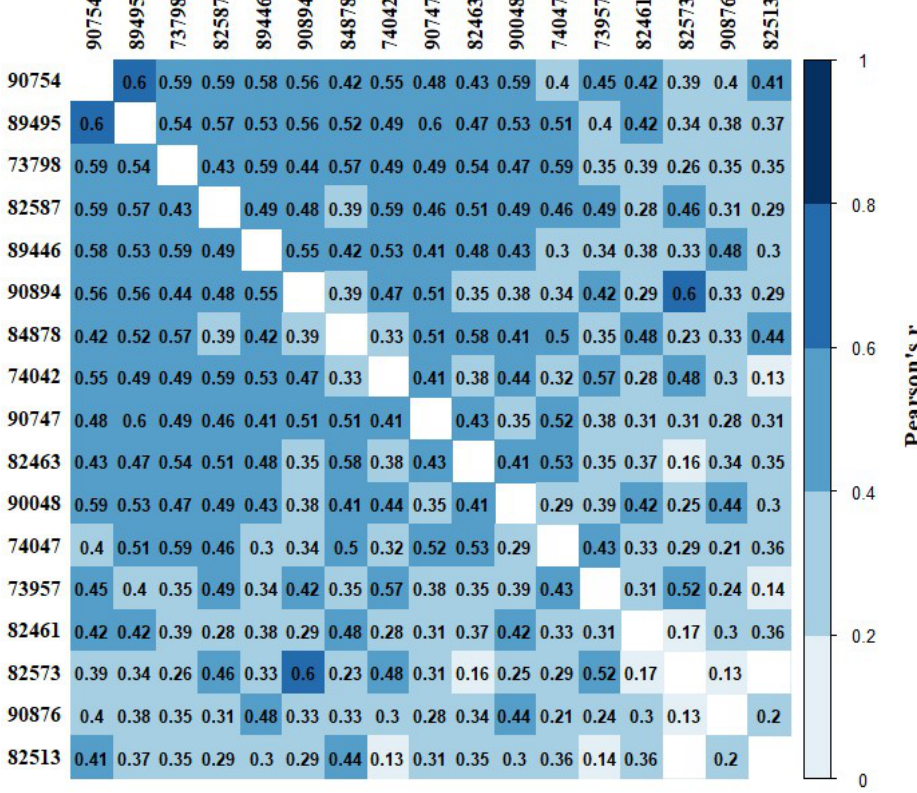
Figure A19. Pearson’s correlation coefficients of the pairwise number of warnings received by the bull calves. The colour ramp indicates the degree of correlation from white (0) to blue (1) with a darker blue indicating a stronger correlation. Correlation coefficients are only shown for significant results. The numbers around the edge of the matrix are the ID numbers of the bull